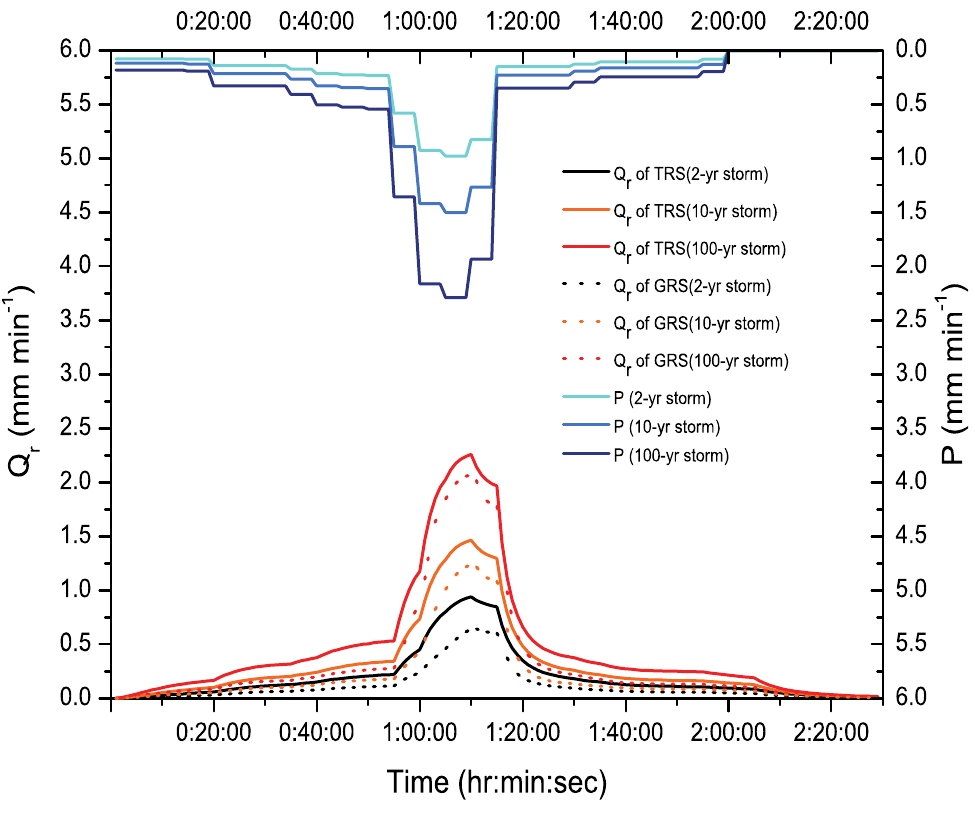
Figure 5. Comparison of runoff hydrographs between TRS and GRS for 3 single precipitation events (2-yr, 10-yr, and 100-yr). P: precipitation; Q r : discharge of runoff. Table 6. Comparison between the TRS and GRS in single event simulation. 415